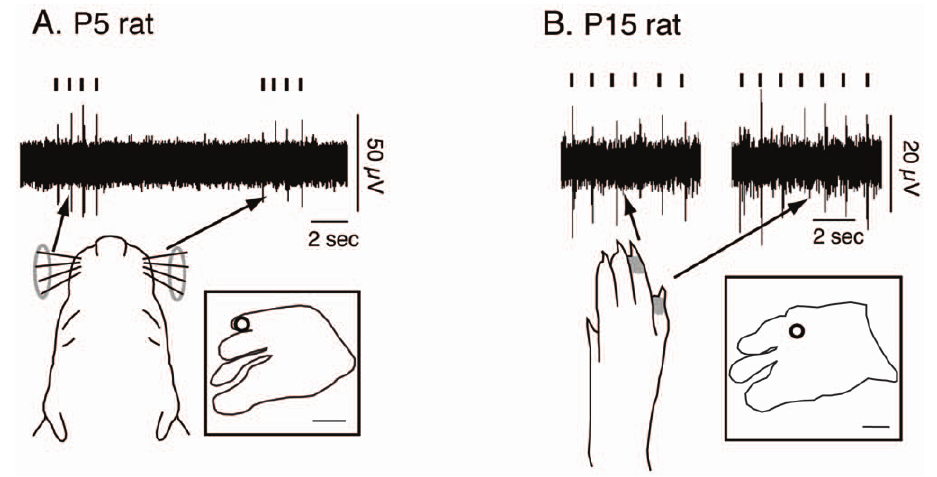
Figure 15. Representative traces of multi-unit activity in a P5 (A) and P15 (B) rat. A) Multi-unit activity in response to stimulation of both ipsilateral (left) and contralateral (right) vibrissae. Tic marks indicate the temporal pattern of stimulation. The inset box includes a depiction of S1 with the recording site indicated by an open circle (scale=1 mm). B) Multi-unit activity in response to stimulation of toe 4 (left) and toe 5 (right) of the contralateral hindpaw. The receptive field for the neurons is indicated in gray on the schematic of the contralateral hindpaw. The inset box includes an illustration of S1 with the recording site marked by an open circle (scale=1 mm).